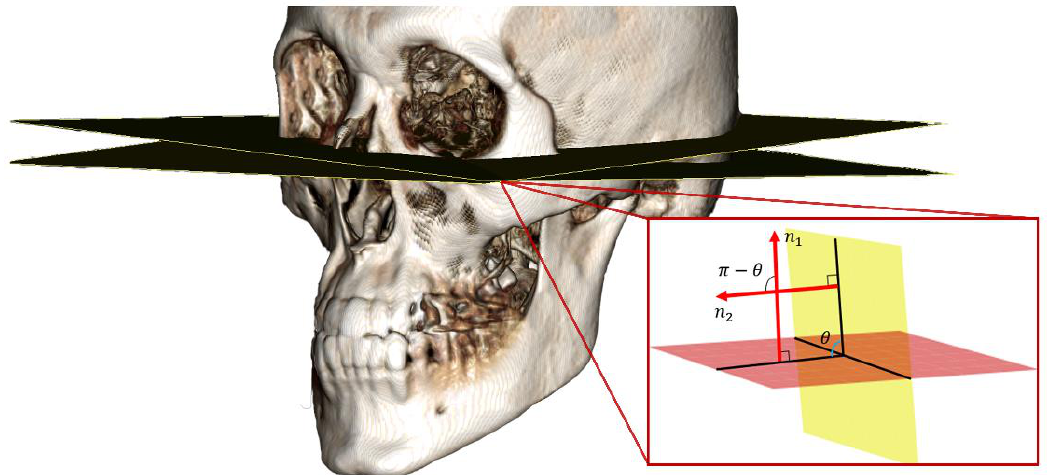
Figure 2. Calculation of the angle 𝜃 between the different Frankfort horizontal (FH) planes, where n 1 and n 2 are the normal vectors of the two planes.